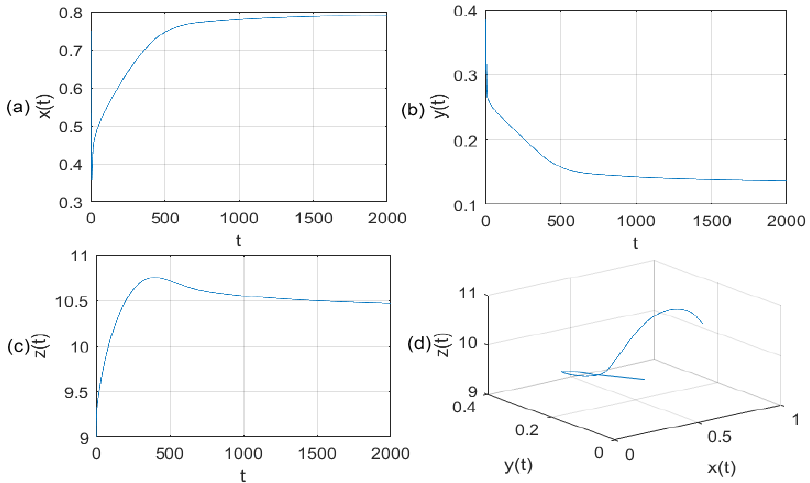
Figure 6. Evolution of the system states with =0.6 . ( a ) x ( t )- t ; ( b ) y ( t )- t ; ( c ) z ( t )- t ; ( d ) x ( t )- y ( t )- z ( t ).